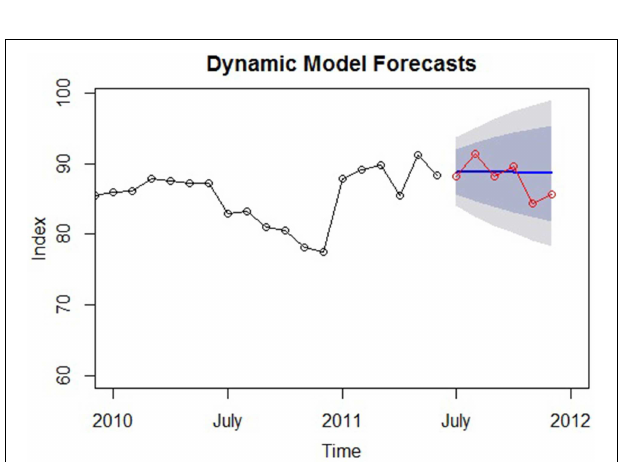
FIGURE 9 | ACF and PACF of the cubic model residuals used to determine the number of AR and MA terms in an ARIMA model.